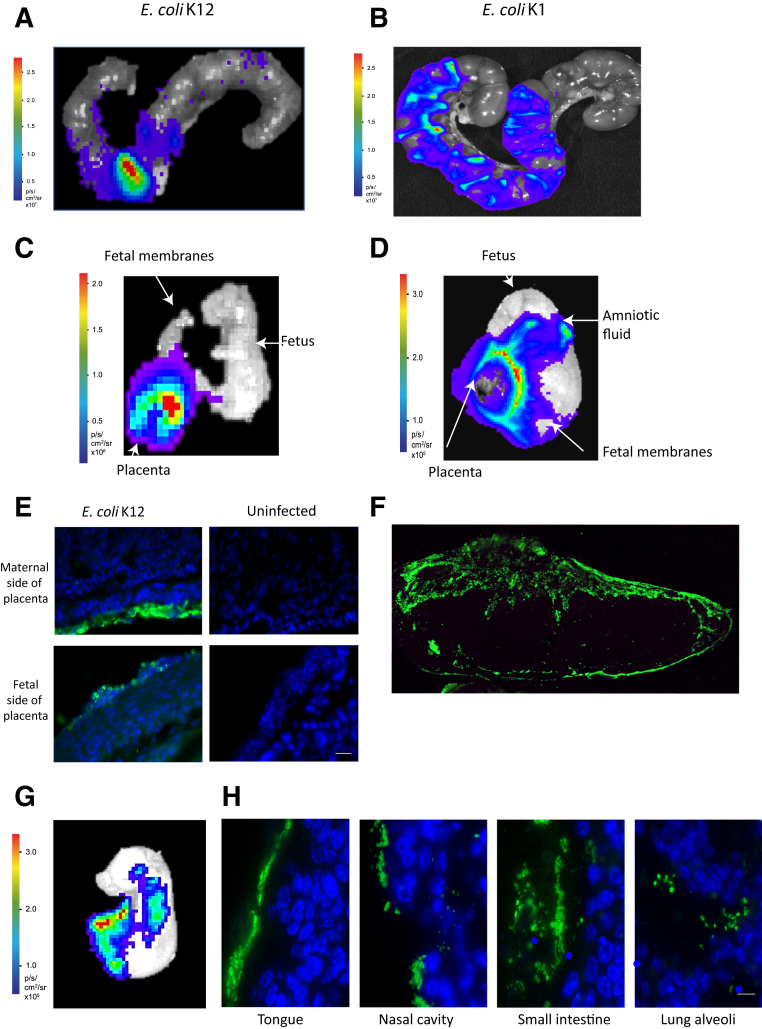
Escherichia coli K12 and E. coli K1 ascends into the uterine cavity by 18 hours after intravaginal infection. A and B: Both E. coli K12 (A) and E. coli K1 (B) are seen in the uterine cavity at 18 hours after bacterial administration. C: Bacteria are detectable only in the placentas of E. coli K12–infected dams. D: In E. coli K1–infected dams, however, bacteria are detectable in the fetal membranes, the placenta, and the amniotic fluid (fetus with intact membranes). E and F: Immunofluorescence detection of E. coli in placental samples derived 18 hours after intravaginal E. coli K12 infection (E) and intravaginal E. coli K1 infection (F); E. coli is detected on both sides of the placenta. G and H:E. coli K1 is detected in the fetus 24 hours after intravaginal infection in the mother (G); immunofluorescence detection of E. coli in the fetus shows that bacteria are specifically present in the gastrointestinal and respiratory tracts (H). Scale bars: 25 μm.